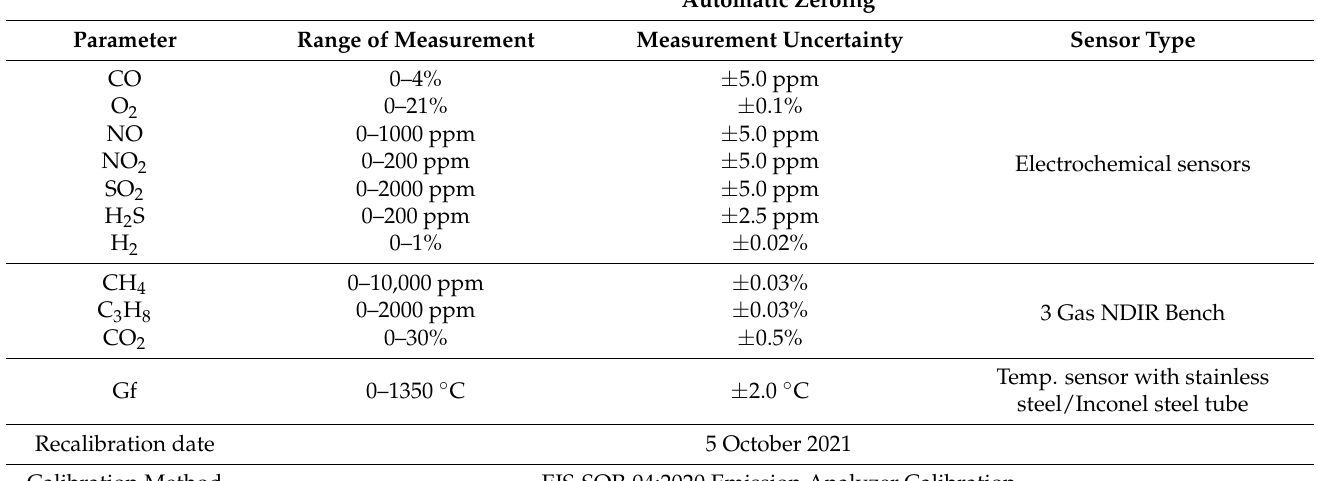
Table 2. MRU Multi-gas analyzer specifications.